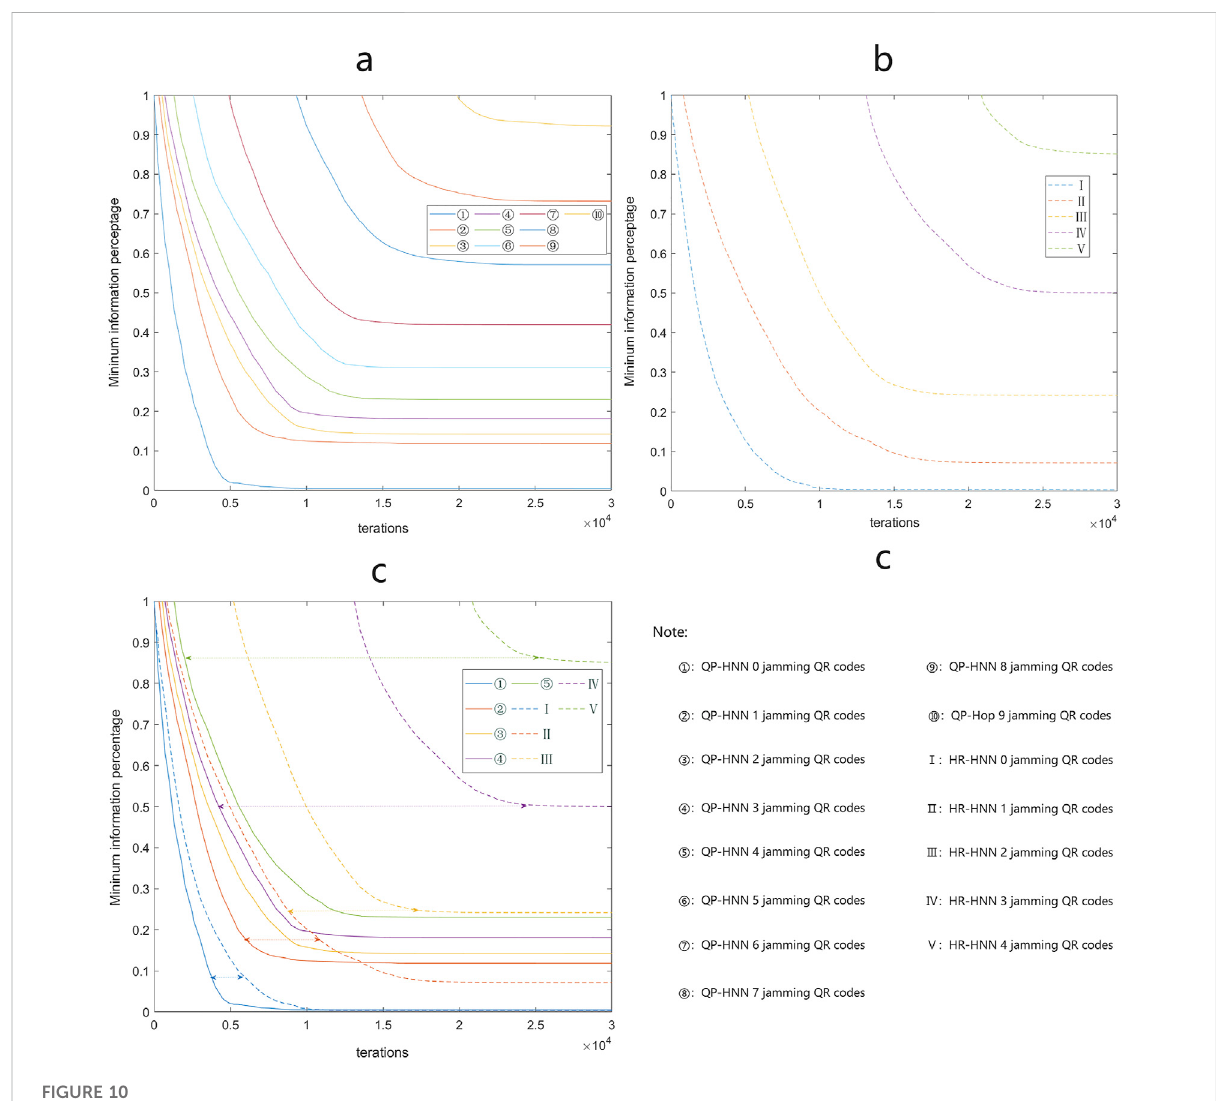
FIGURE 10 HR-HNN and QP-HNN convergence and resilience tests.